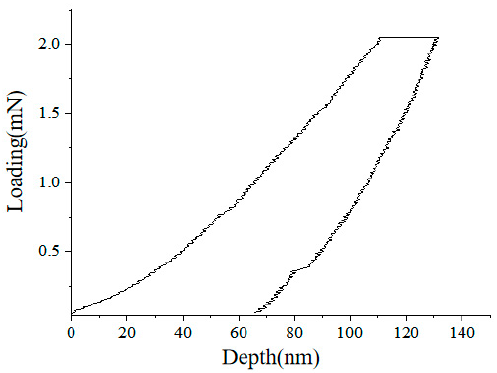
Figure 12. Load-depth curve of the aggregate nanoindentation test.